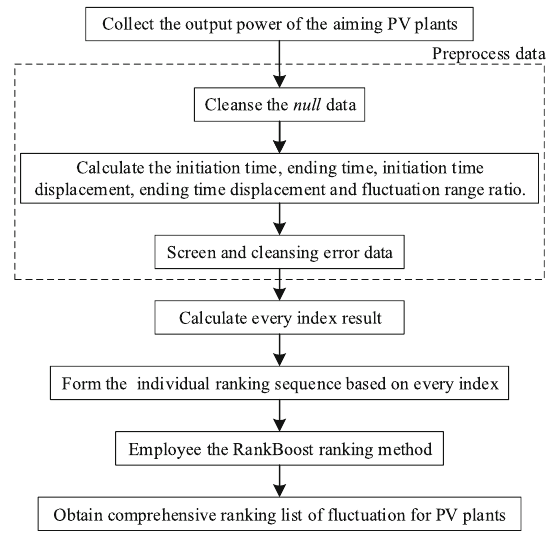
Fig. 4 The procedure of fluctuation